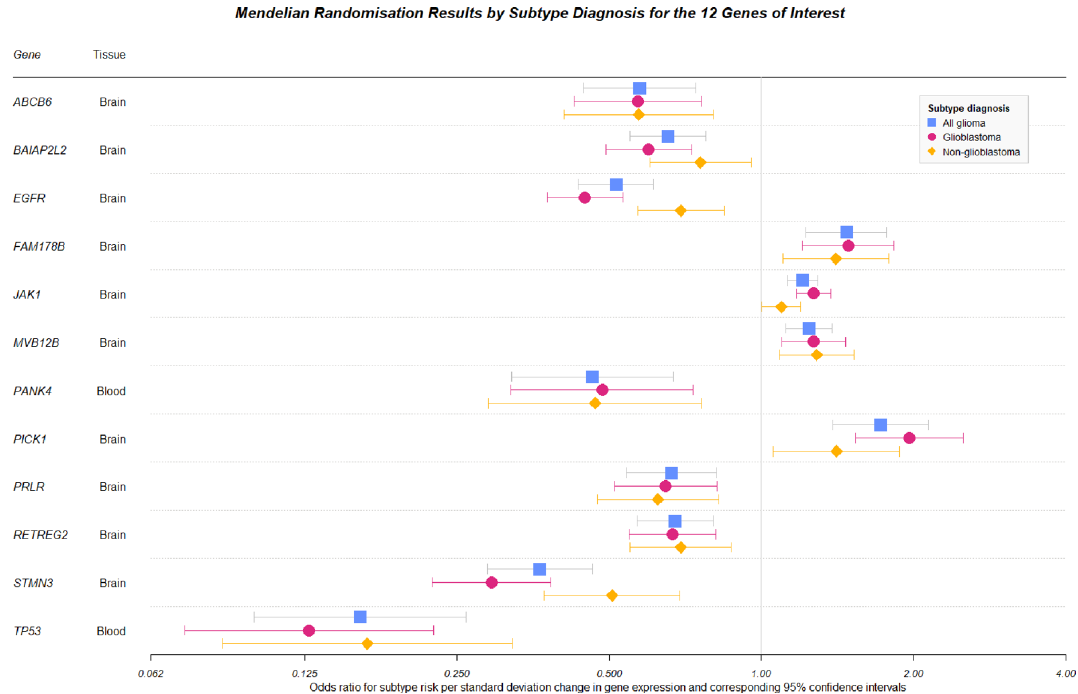
Figure 3. Forest plot of Mendelian randomisation results for the 12 genes which had robust MR and colocalisation evidence and also passed the Steiger filtering analysis.